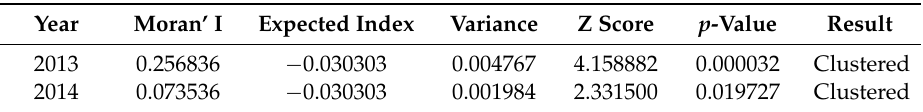
number in 2013 and 2014 in